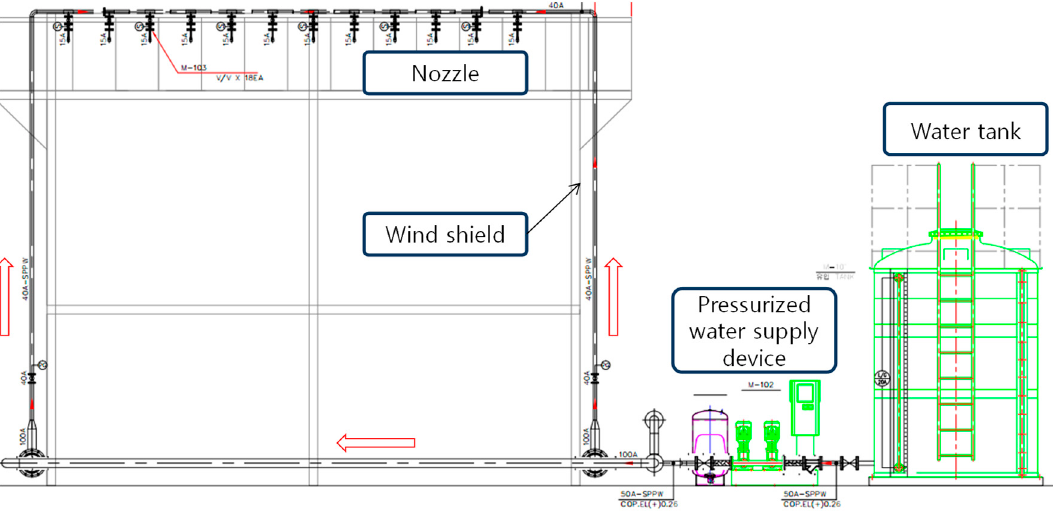
Figure 1. Design of rainfall simulator.